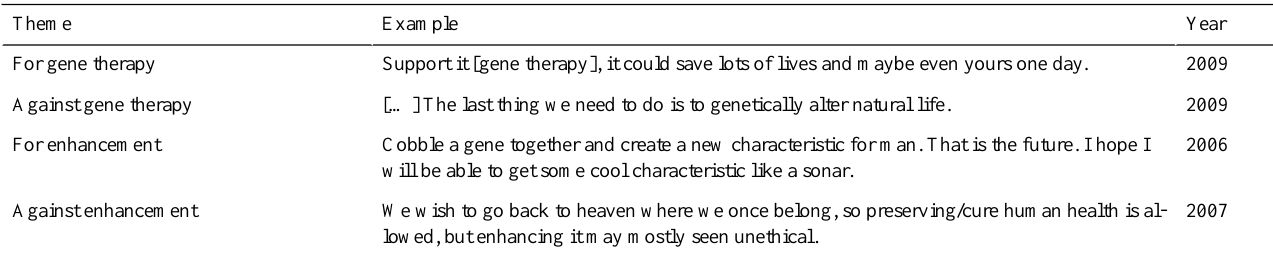
Table 5. Examples of attitudes towards gene therapy and its applications.